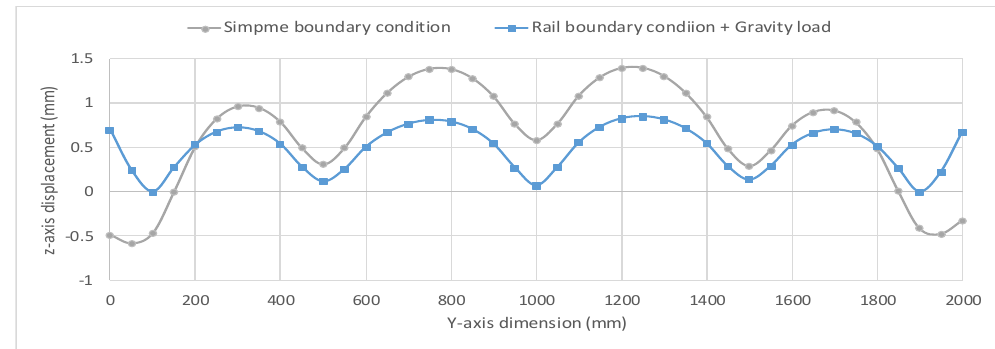
Figure 14. Z-axis displacement distribution along line T of Sequence B-10 under two different boundary conditions. J. Mar. Sci. Eng. 2020 , 8 , x FOR PEER REVIEW